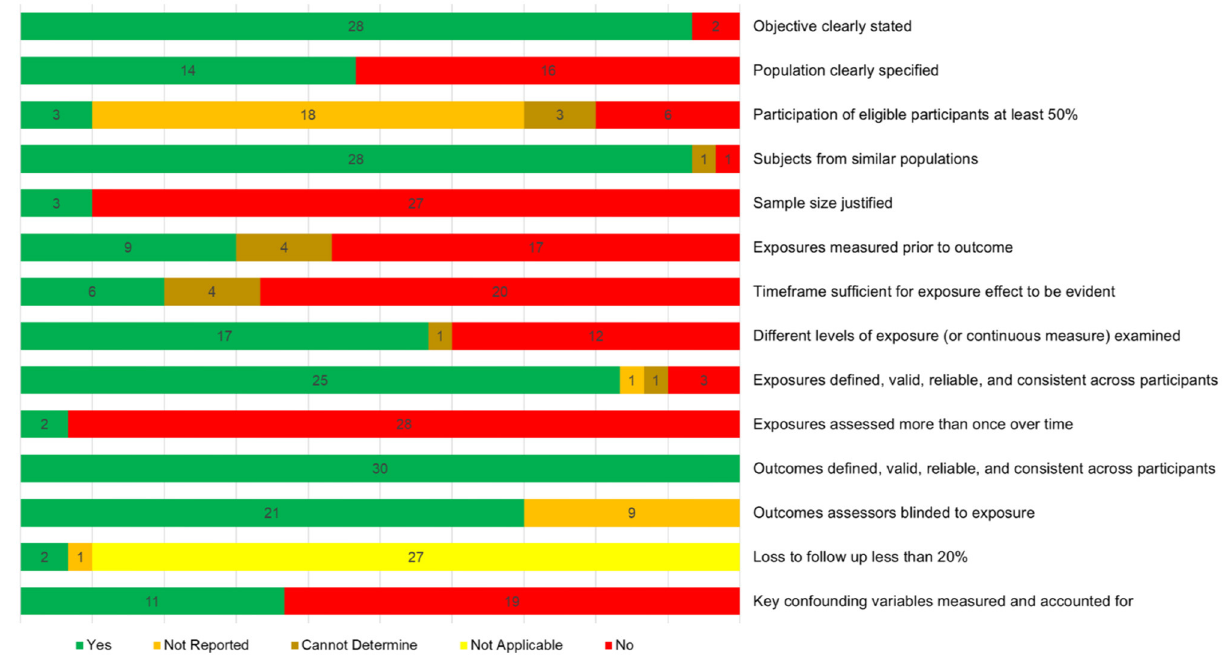
FIGURE 7 | Quality assessment summary showing how many studies were given each of the five possible judgements for each of the assessment